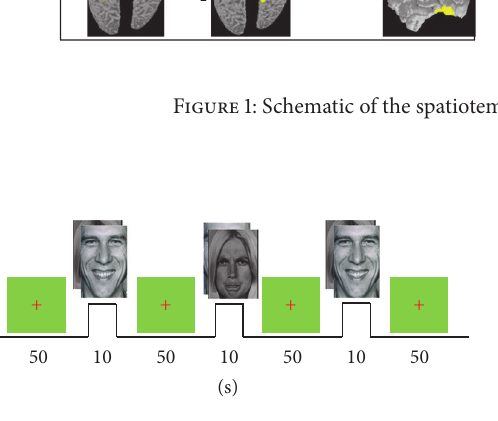
Figure 2: Experimental paradigm—rest state: subjects were shown a green background (50 seconds); active state: display of face image (two categories: unpleasant and pleasant); subjects are to squeeze a ball with right hand for 10 seconds if image was perceived as